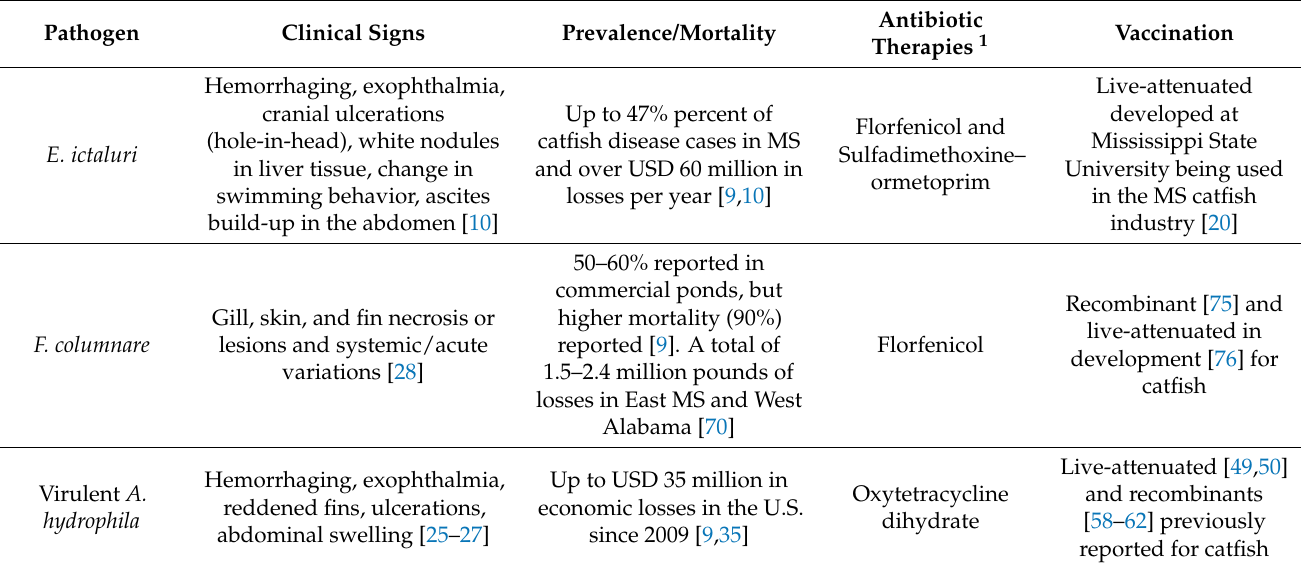
Table 1. Summary of E. ictaluri , F. columnare , and virulent A. hydrophila infections in catfish